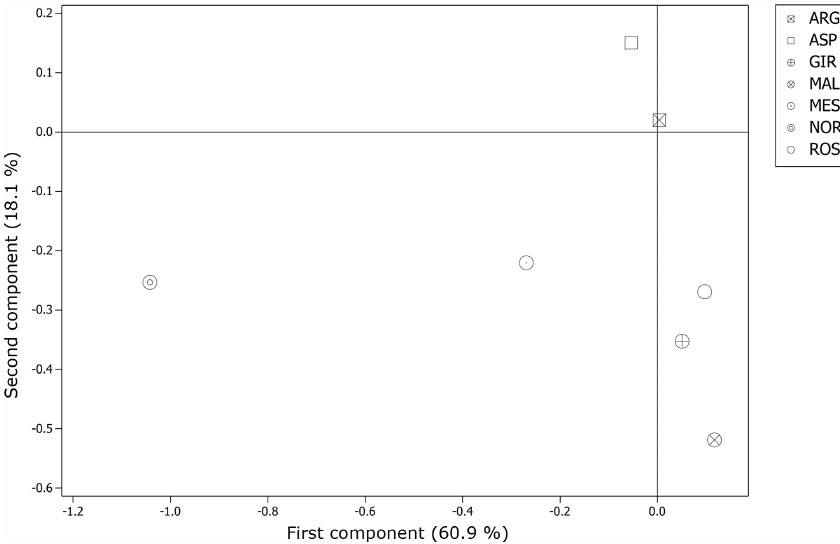
of founders of the Norwegian goat breed (Hayes et al.,